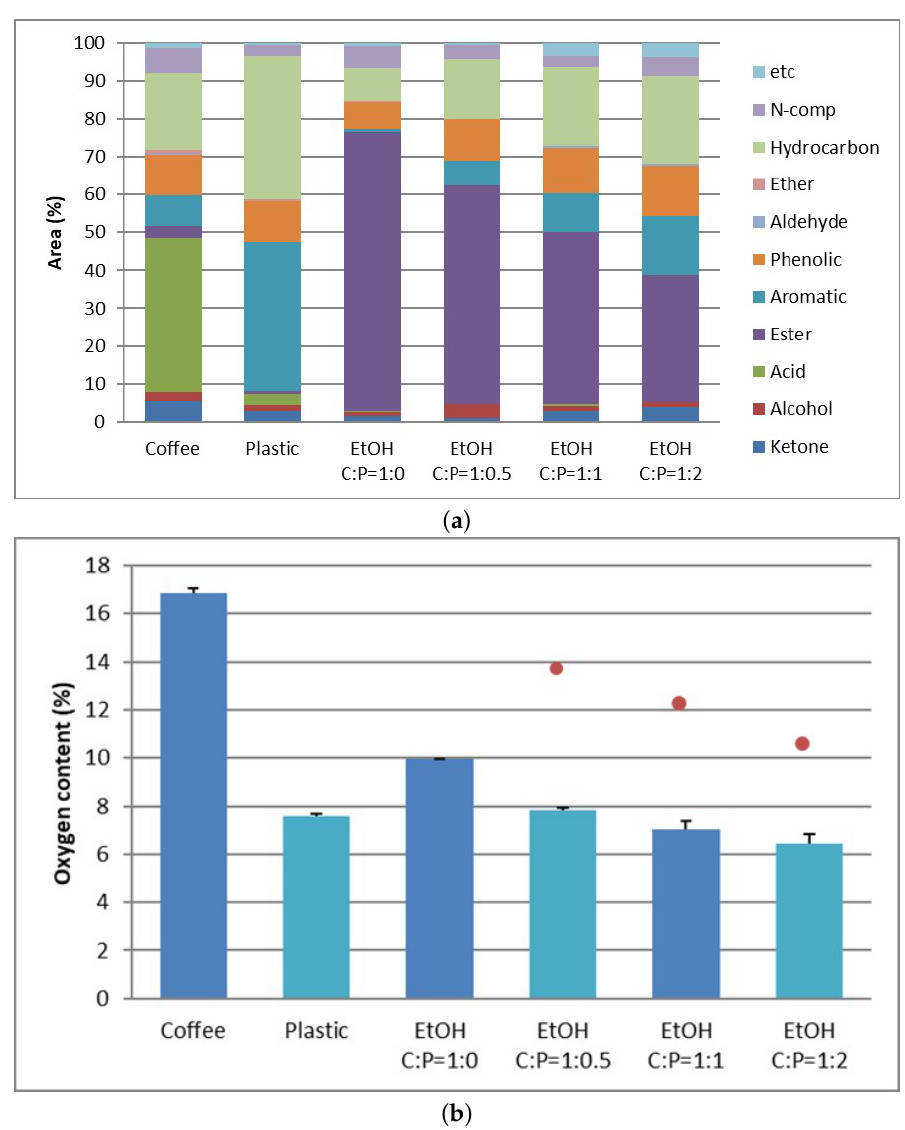
Figure 4. Characteristics of coffee biocrude oil, plastic pyrolysis oil, and upgraded coffee biocrude oils with plastic pyrolysis oil under supercritical ethanol. ( a ) Compositions by GC-MS analysis (C:P is the weight ratio of coffee biocrude oil to plastic pyrolysis oil). ( b ) Oxygen contents